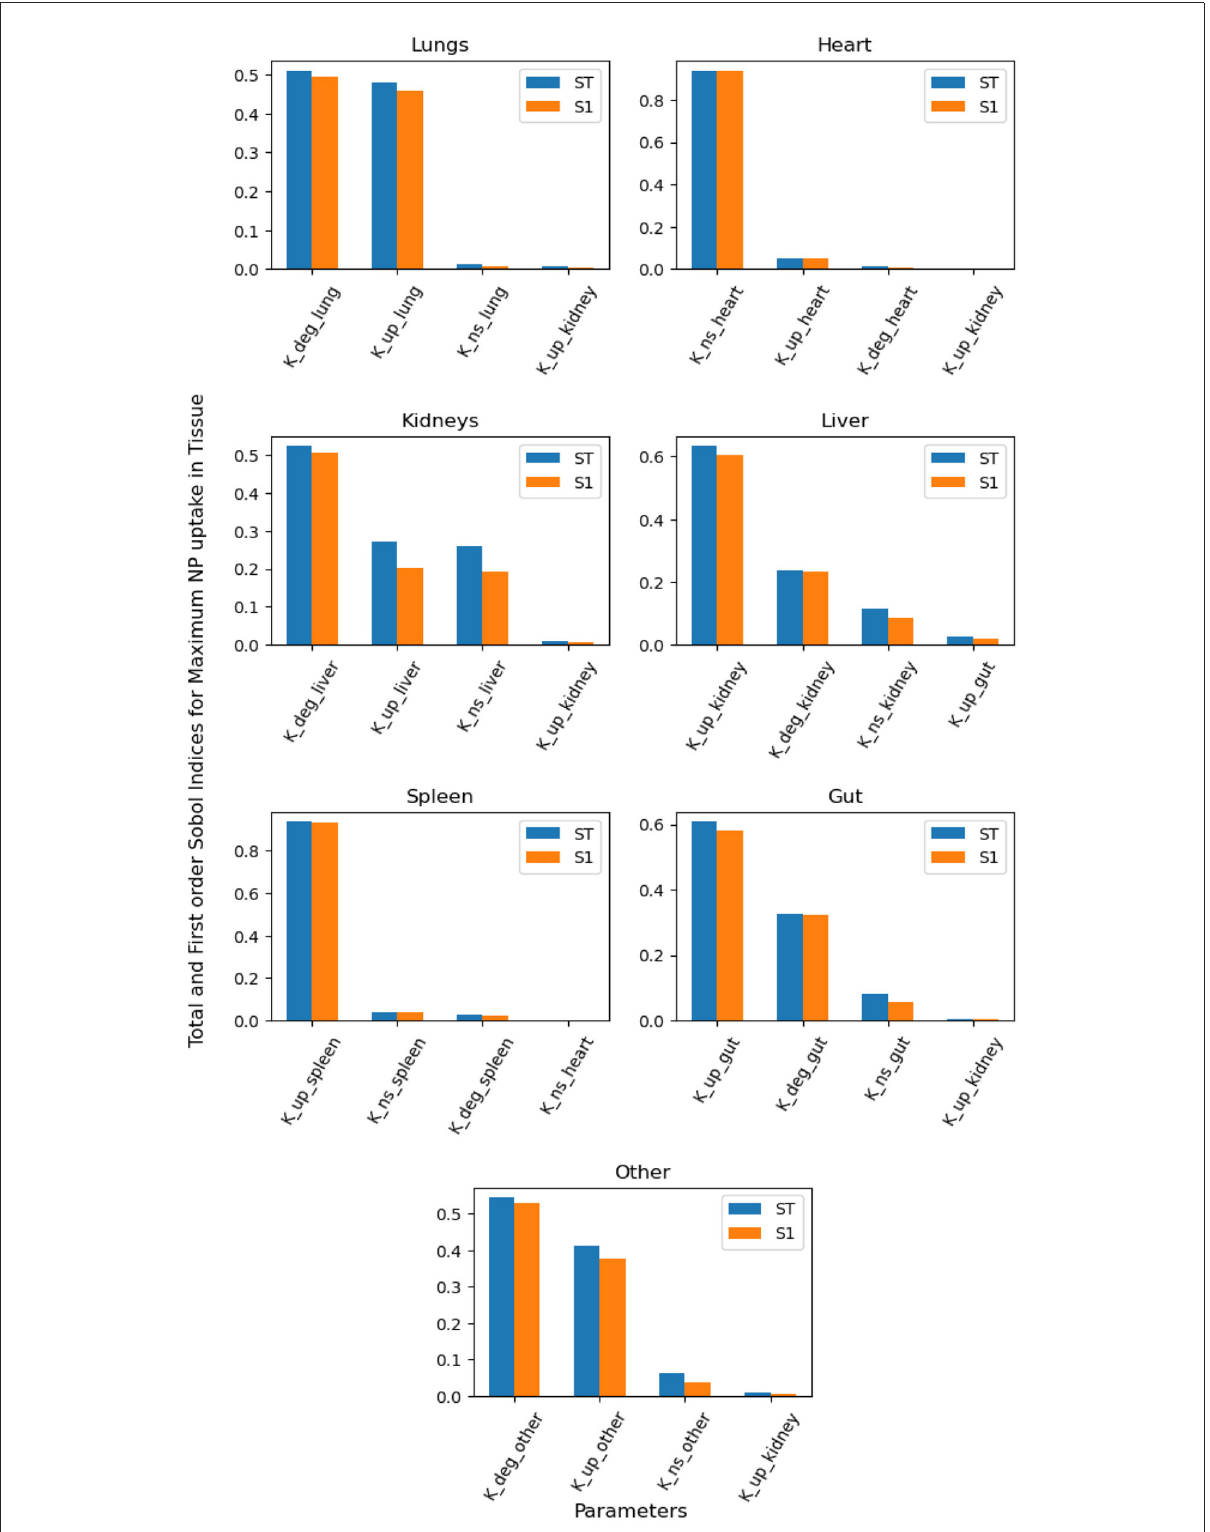
FIGURE5 Global Sensitivity Analysis: Total order and First-order Sobol indices of K deg , K up , and K NS parameters, for global sensitivity analysis performed on maximum NP uptake in organ